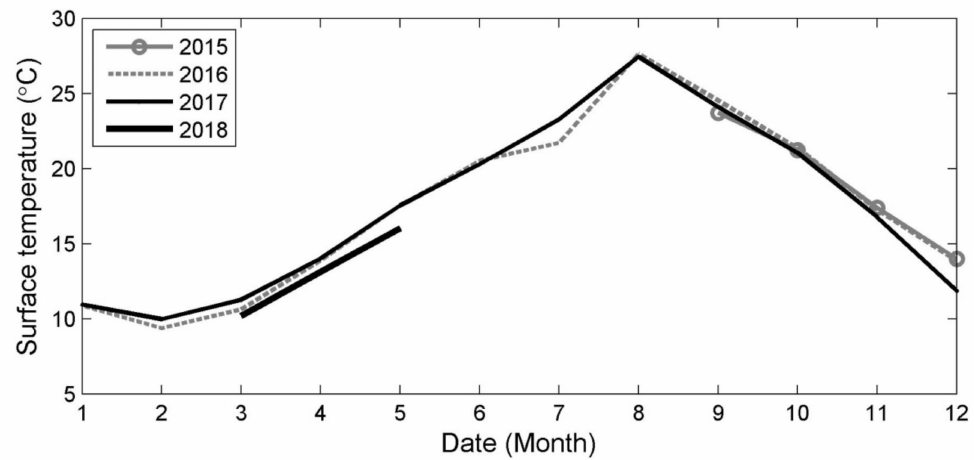
Figure 8. Monthly annual variations of the averaged surface water temperature retrieved by the Korea Ocean Observing and Forecasting System of the Korea Hydrographic and Oceanographic Agency in Jinhae Bay from 2015 to